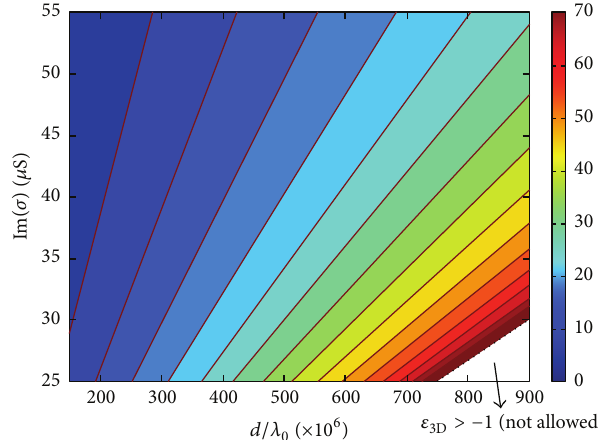
Figure 1: Relative error of the dielectric slab model with respect to normalized 𝑑 and 𝜎